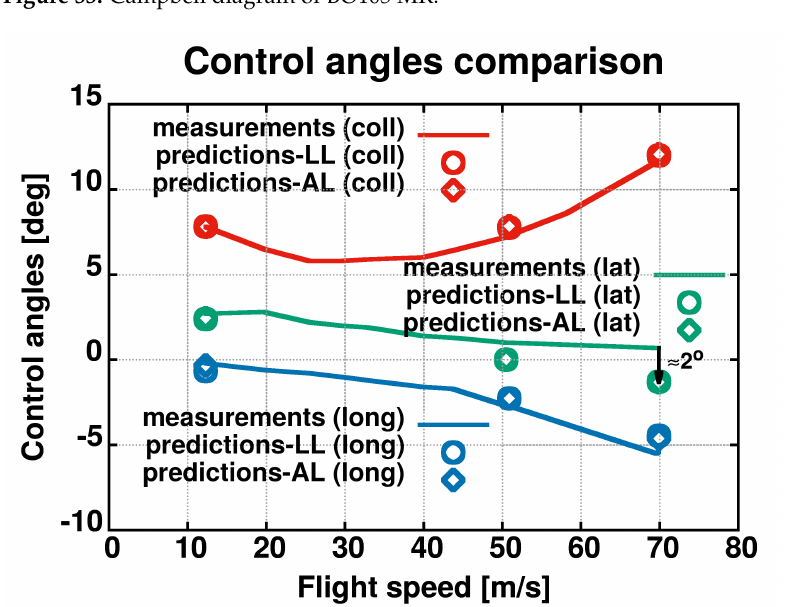
Figure 34. Control angles comparison. Trimmed simulation values vs experimental